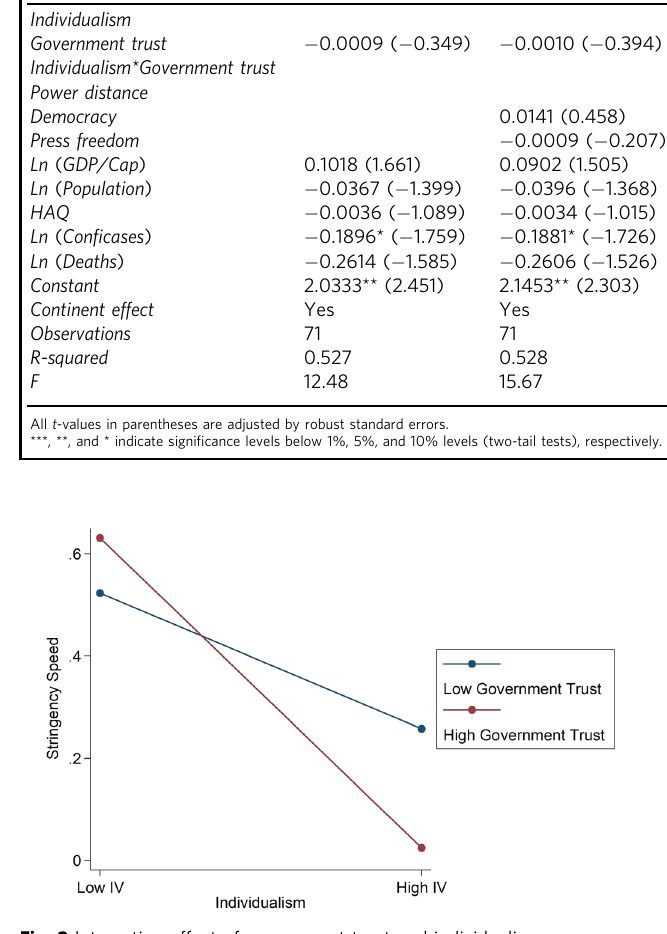
Fig. 2 Interaction effect of government trust and individualism on stringency